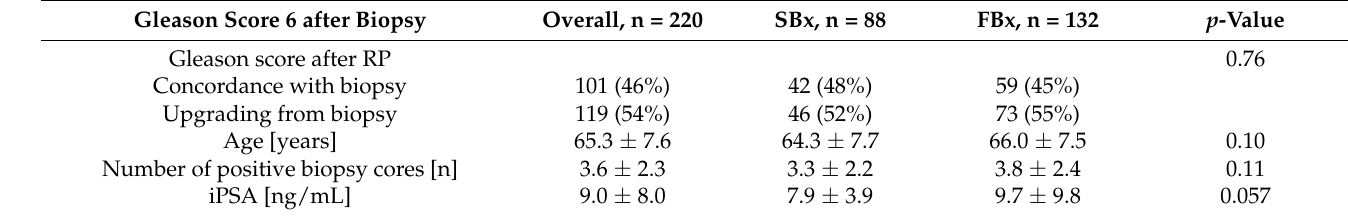
Table 3. Baseline characteristics of patients undergoing FBx versus SBx with a Gleason score 6 after biopsy. Values are presented as mean ± standard deviation or n (%). The t -test was performed for comparisons between continuous variables and the chi-squared test between categorical variables. iPSA: prostate-specific antigen at FBx, RP: radical prostatectomy.